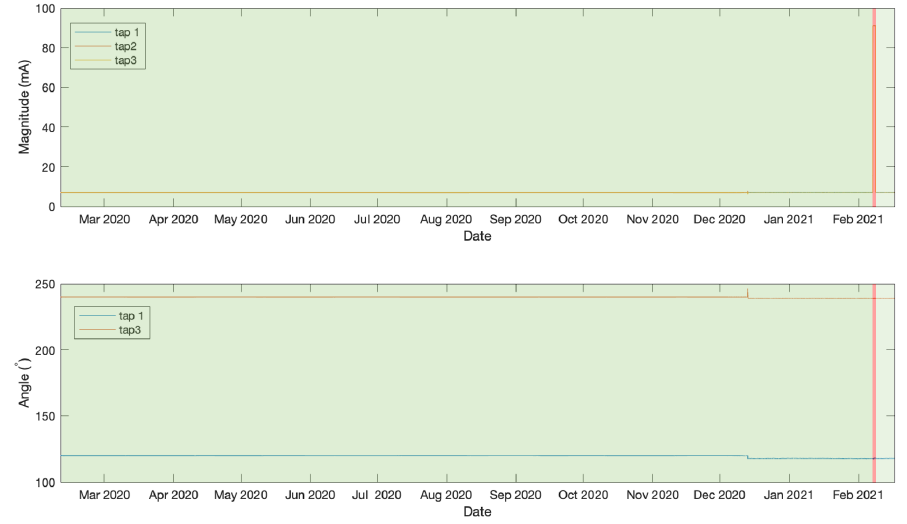
Figure 9. Anomaly detection result on magnitude and angle data in experiment